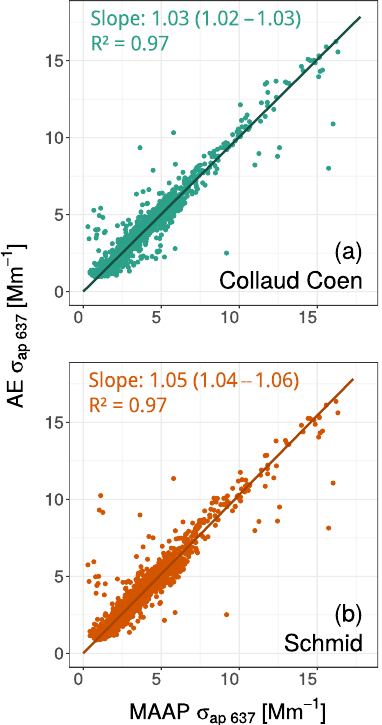
Figure 4. Scatter plot of (a) Collaud Coen and (b) Schmid correc- tions results vs. MAAP absorption coefficients (all data at 637nm). The fit was obtained by applying a standardized major axis regres- sion.